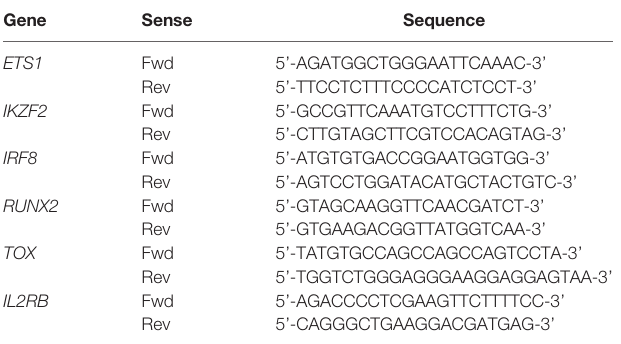
TABLE 1 | qPCR primers for RNA-seq con fi rmation.